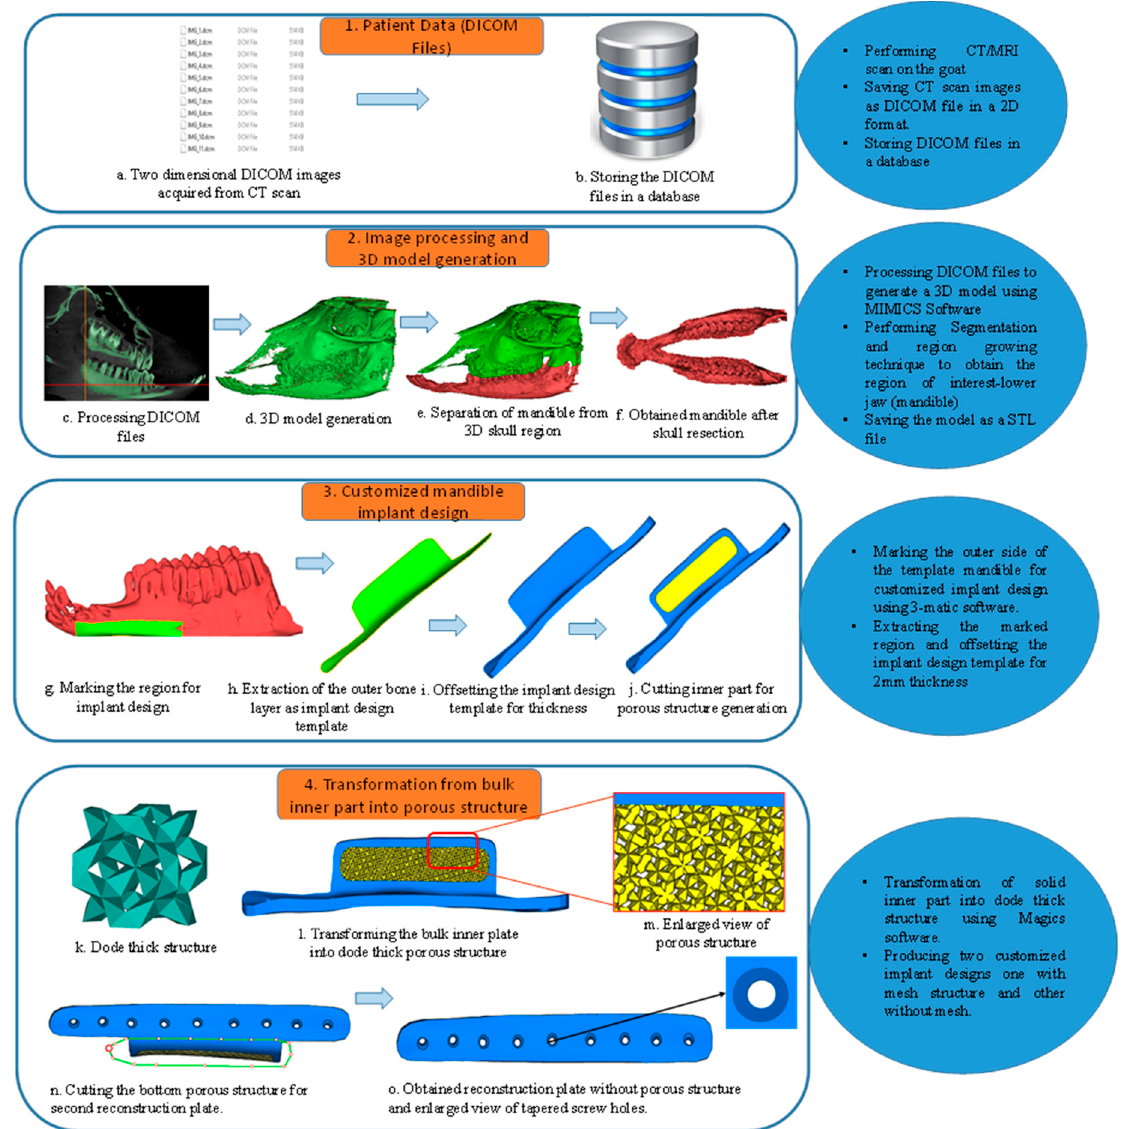
Figure 2. Customized goat implant design steps from DICOM files.